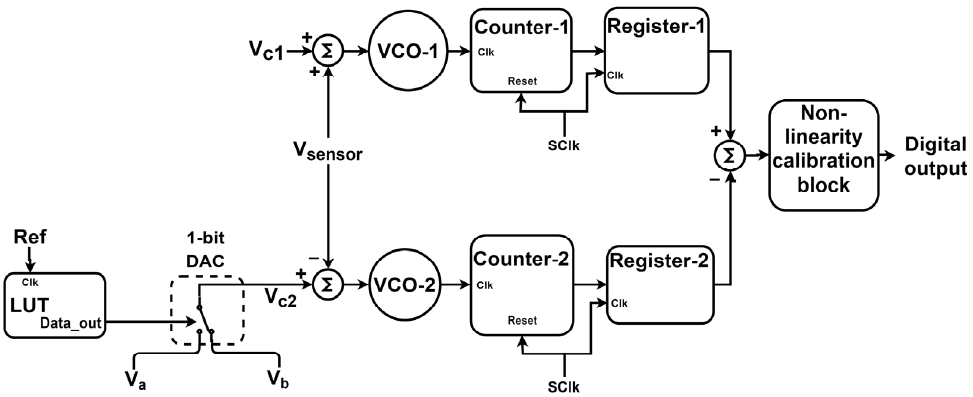
Figure 3. Equivalent circuit during Phase-II.